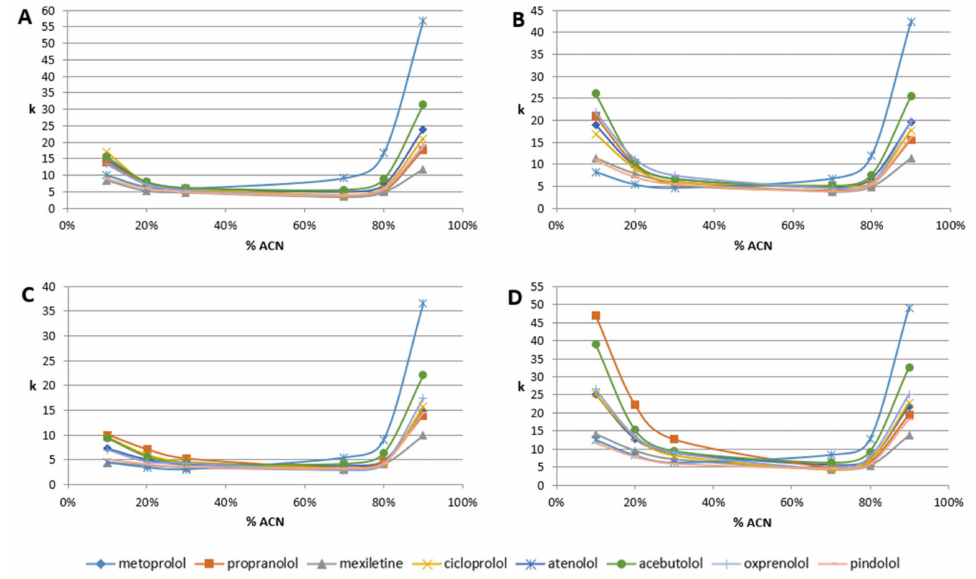
Figure 3. Retention factor (k) dependence for different mobile phase composition (%ACN in 10 mM ammonium acetate in water, pH equal 7.5); ( A )-Diol-P-Benzyl, ( B )-Diol-P-C18, ( C )-Diol-P-C10, and ( D